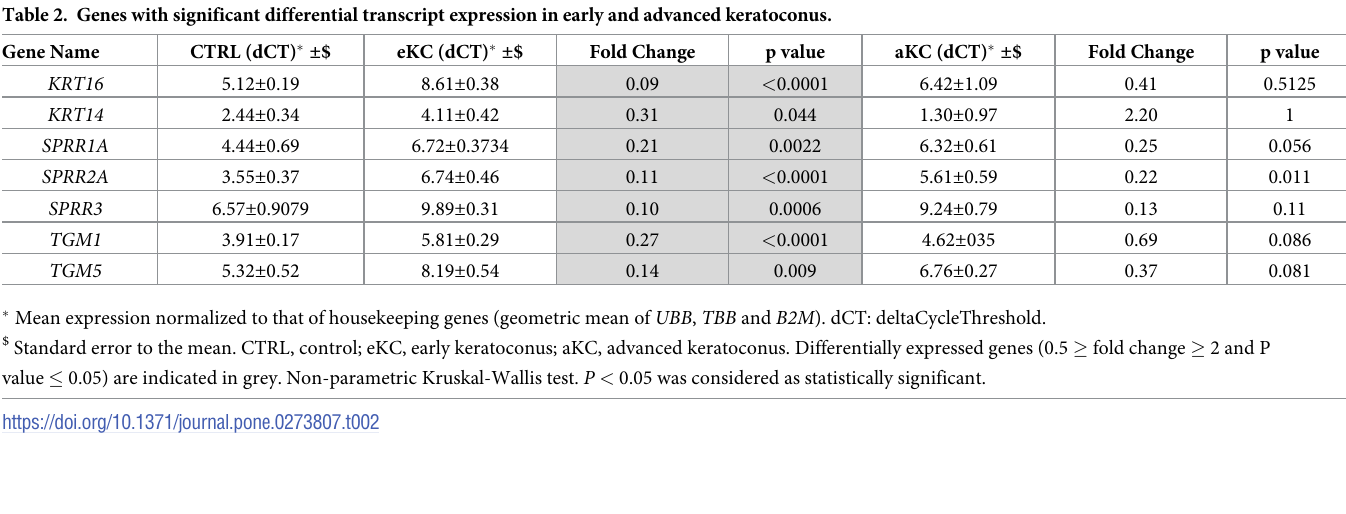
Fig 1. Differentially expressed transcripts in early and advanced keratoconus. Box and whiskers plots of gene expression in the corneal epithelium of control (CTRL; n = 23), early keratoconus (eKC; n = 22) and advanced keratoconus (aKC; n = 6). Transcript level expressed as mean of delta cycle threshold (dCT) normalized to housekeeping genes. Non-parametric Kruskal-Wallis test. P < 0.05 was considered as statistically significant. � , P value < 0.05.